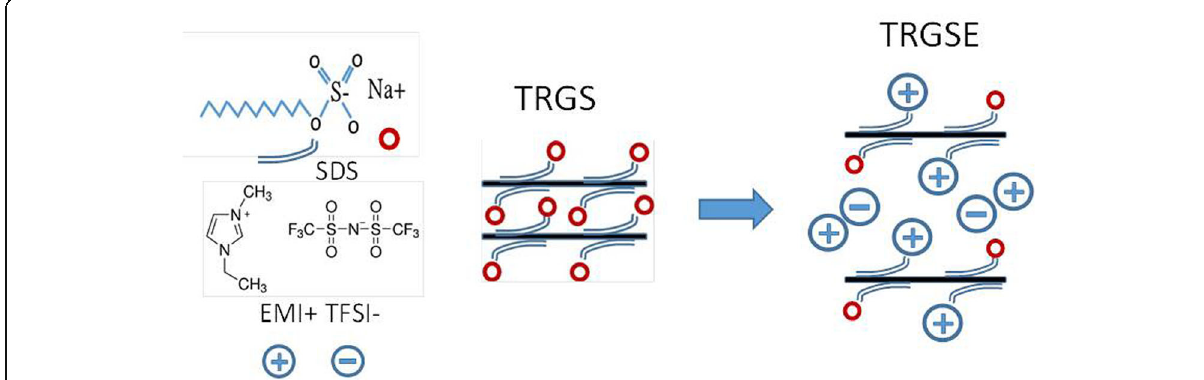
Fig. 1 The schematic depicts the process to enlarge the interlayer distance between TRG sheets through the Coulomb force